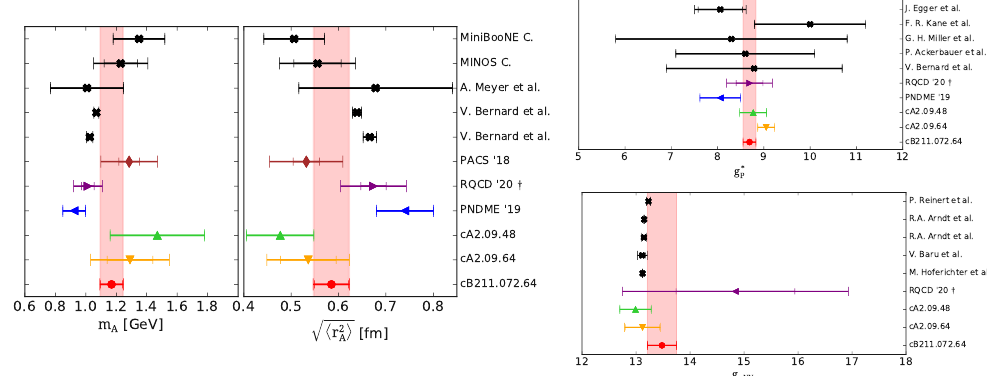
Figure 6: Left panel: Results on the isovector axial mass m (left) and the axial ra- A (cid:113) 〈 r 2 〉 (right). Right panel: Results for the muon capture coupling constant, g ∗ dius A P (top) and the pion-nucleon coupling g π (bottom). Red circles with the associated NN red band are the results using the cB211.64 ensemble. Results re also shown for two = 2 twisted mass fermion ensembles with a = 0.094 fm and L = 4.5 fm (green N f up triangle) and 6.0 fm (orange down triangle), for PNDME [ 19 ] (blue left-pointing triangle), for RQCD [ 22 ] (purple right-pointing triangle, with † are results obtained after chiral and continuum extrapolation), and for PACS [ 23 ] (brown rhombus). In- ner error bars are statistical errors while outer errors bars include systematic